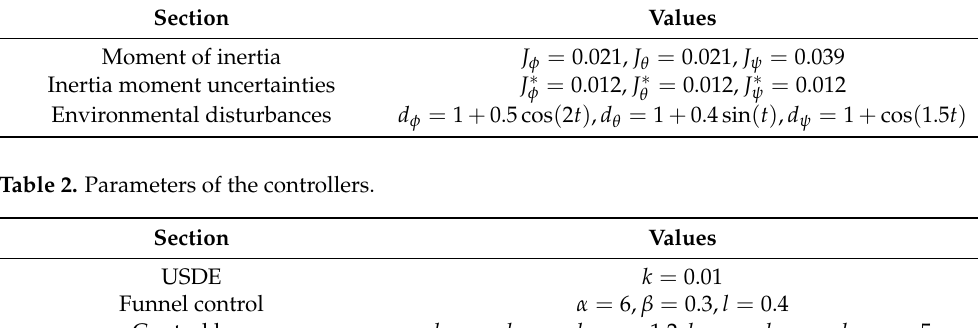
Table 1. Parameters of quadrotor attitude dynamics.